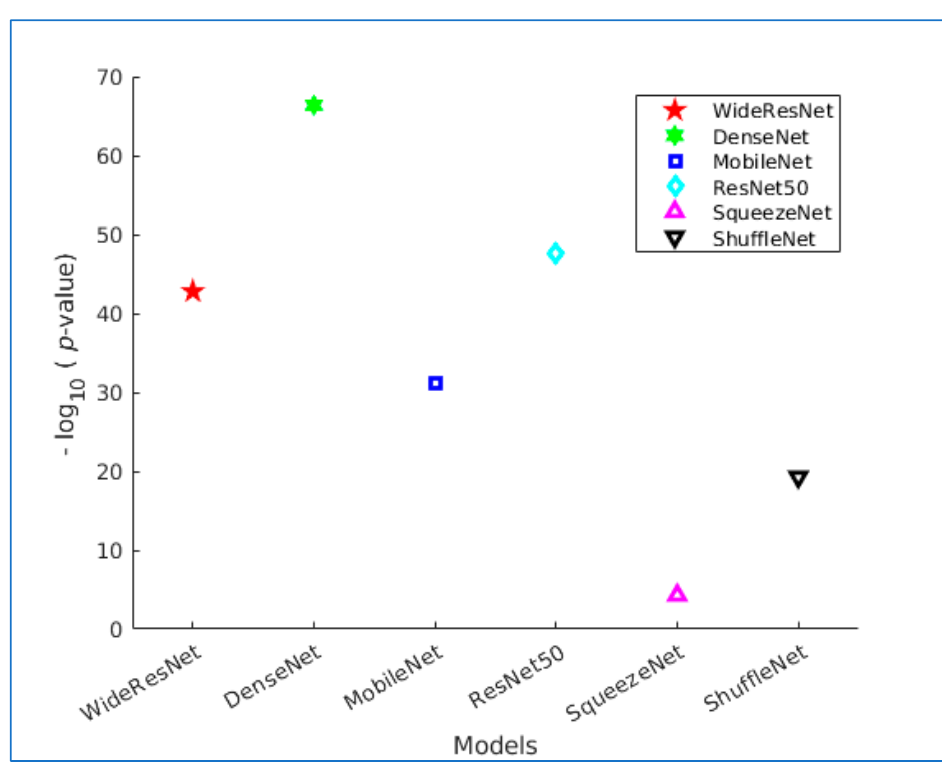
Figure 11. Wilcoxon Signed-Rank statistical significance test analysis over the deployed models between the proposed hierarchical approach and conventional approach for masked face age estima- tion. In every test, models give a p -value of less than 0.05 which statistically proves that the model’s performances are significantly different. The p -values are presented in the form of −𝑙𝑜𝑔 (cid:2869)(cid:2868) (𝑝 − value) for clear perception.